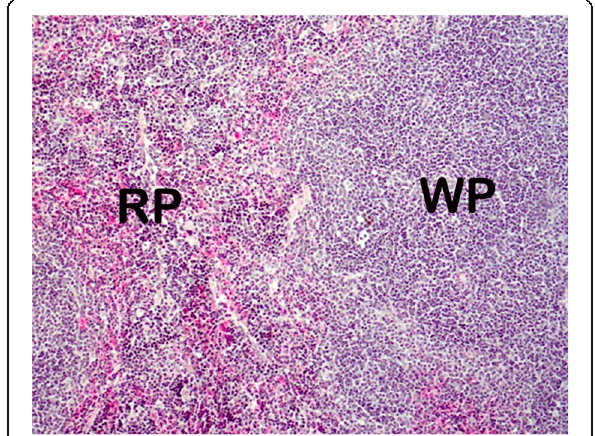
Fig. 6 Histological sections of spleen from the mice treated with PBSG at the rate of 0.1 ml/10 g as the extract at 8 hourly for three days consecutive for comparison with the mice treated with extracts of C. swynnertonii . The red and white pulps have a normal size and cellularity. In the red pulp there are discrete areas of red indicative of congestion. Magnifications, 100 x